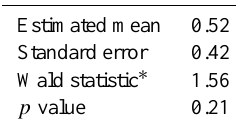
Batch effect can be dropped. Correlation of geologist errors can be dropped. No evidence that between-site variance depends on the distance to the nearest borehole. Evidence that between-geologist variance depends on the distance to the nearest available borehole. Evidence that between-geologist variance depends on the geologist’s experience. Evidence that the relationship between between-geologist variance and experience depends on the distance to the nearest available borehole. No evidence that adding modeller experience improves the model, with the distance to the nearest available borehole already included.